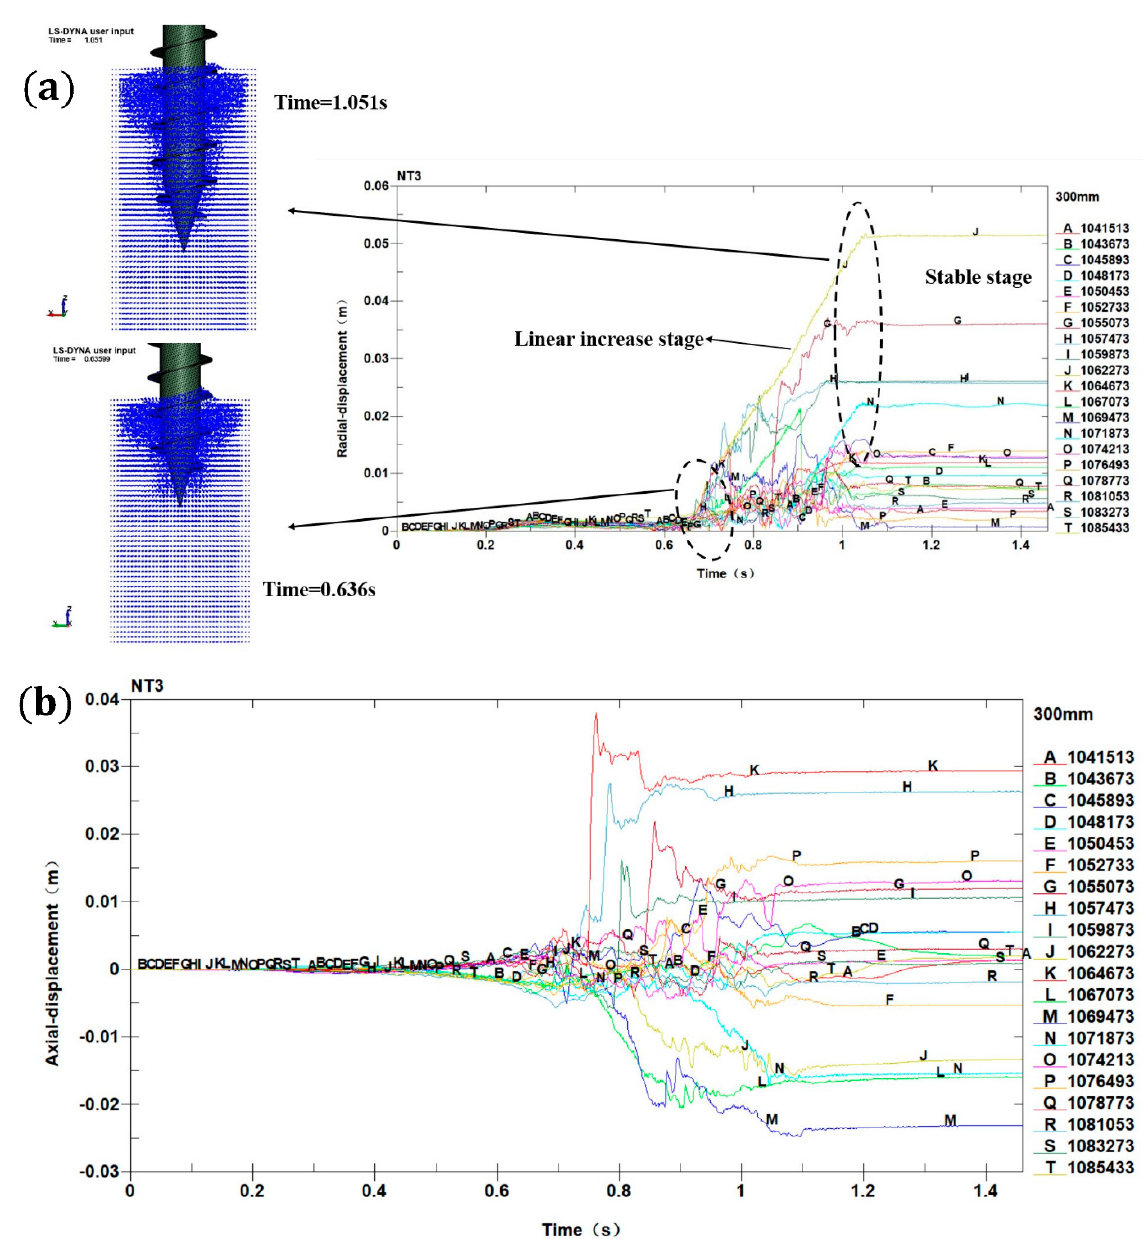
Figure 15. Displacement of the middle soil particles in different directions: ( a ) radial and ( b ) axial.